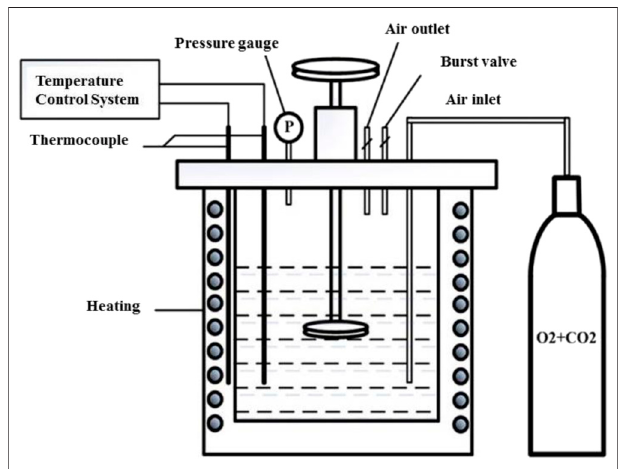
FIGURE 2 | Schematic diagram of high temperature and high pressure autoclave.